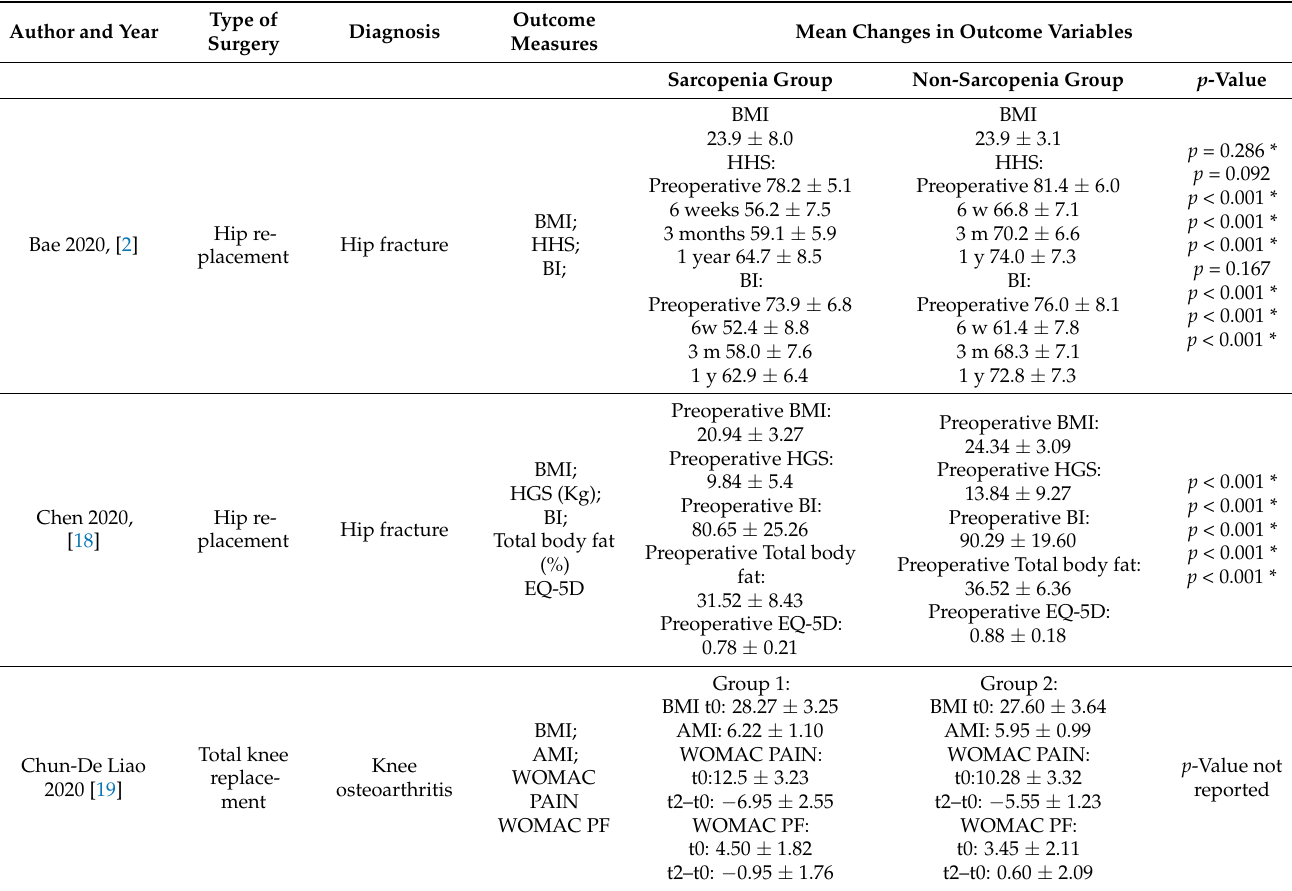
Table 3. Quantitative results of included